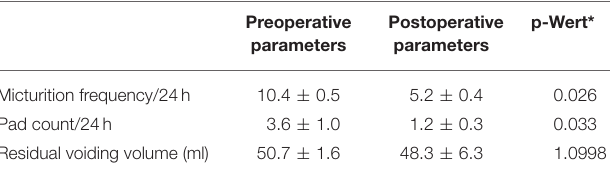
TABLE 3 | Comparison of pre- and postoperative 24-h micturition frequency, 24-h pad count and residual voiding volume (*student’s t -test, α = 0.05). Preoperative parameters